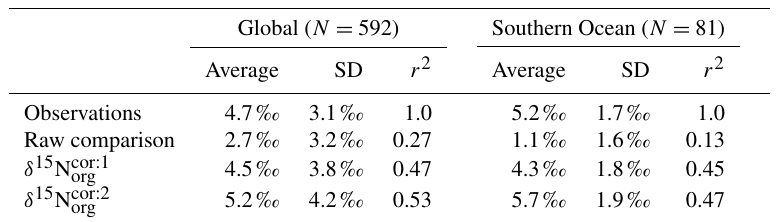
Table 5. Statistical comparison of core-top δ 15 N org with predicted values of the CSIRO Mk3L-COAL ocean model. The corrected vales ( δ 15 N cor : 1 org and δ 15 N cor : 2 org ) account for alteration during early diagenesis following burial.